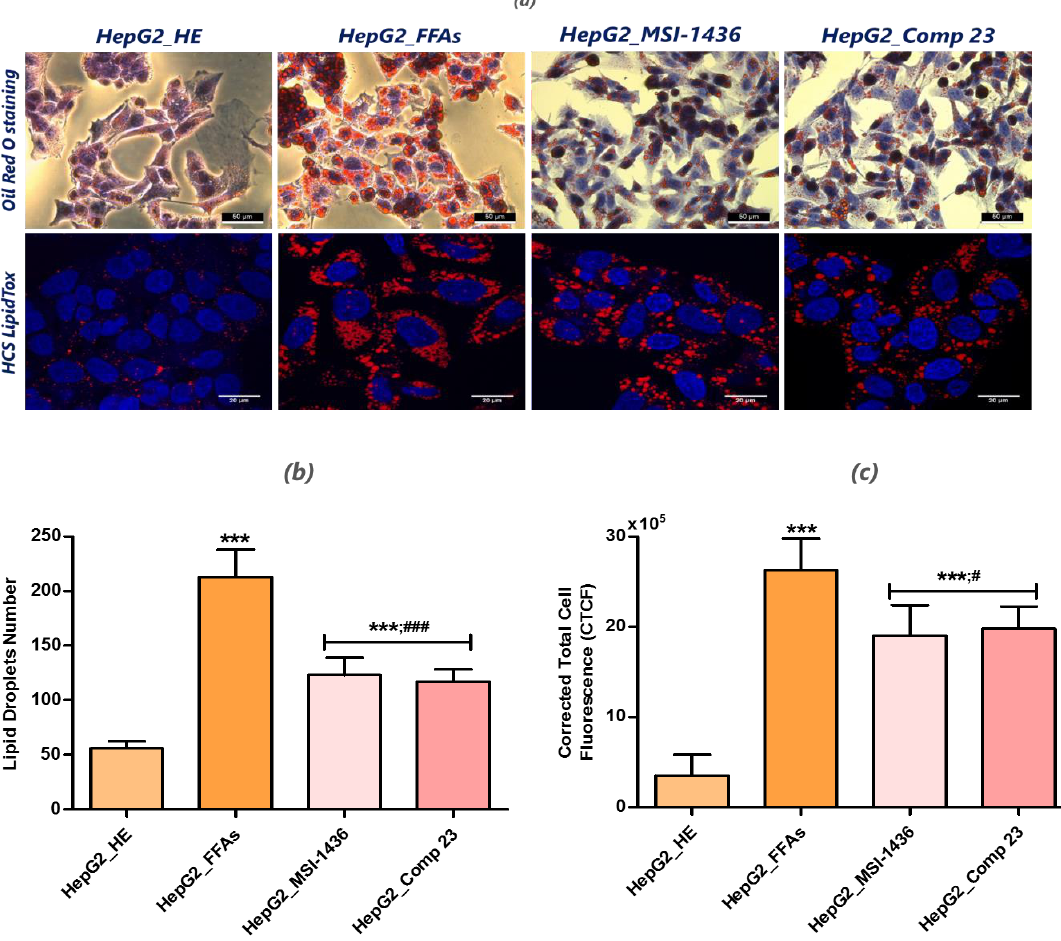
Figure 2. Evaluation of lipid accumulation in HepG2 cells. ( a ) Representative photomicrographs of HepG2 cells treated with FFAs and PTP inhibitors stained with Oil Red O staining at 40-fold magnification and the confocal images of HCS LipidTox stained treated and untreated HepG2 cells; scale bar size 20 µ m; magnification was set to 60-fold. ( b ) The histogram summarizes the mean percentage ± SD of three independent lipid droplet quantifications using the ImageJ software. ( c ) A bar chart representation of the corrected total cell fluorescence (CTCF) for HCS LipidTox calculated using the ImageJ software. An asterisk (*) indicates a comparison of all treated groups to untreated healthy cells. A hashtag (#) refers to a comparison of the PTP inhibitor treated groups to the FFA-